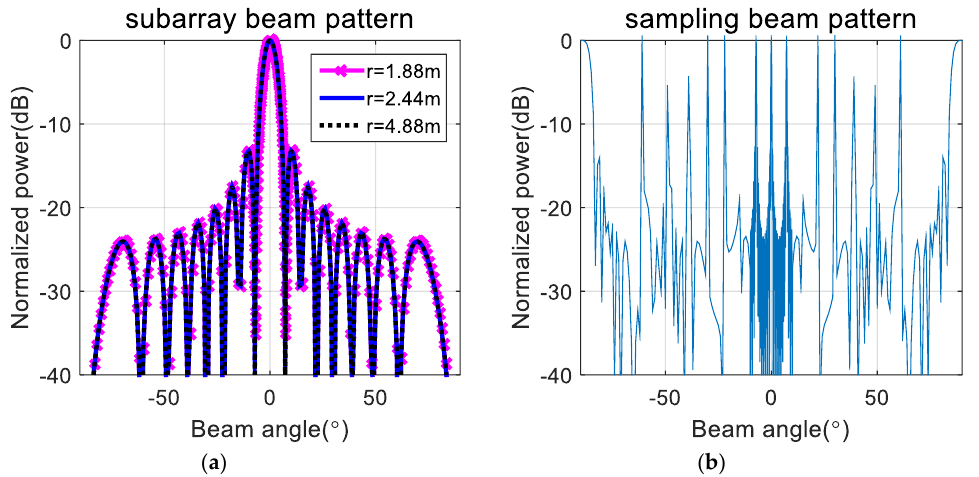
Figure 5. Beam pattern of subarray ( a ) and sampling function ( b ) in far-field.